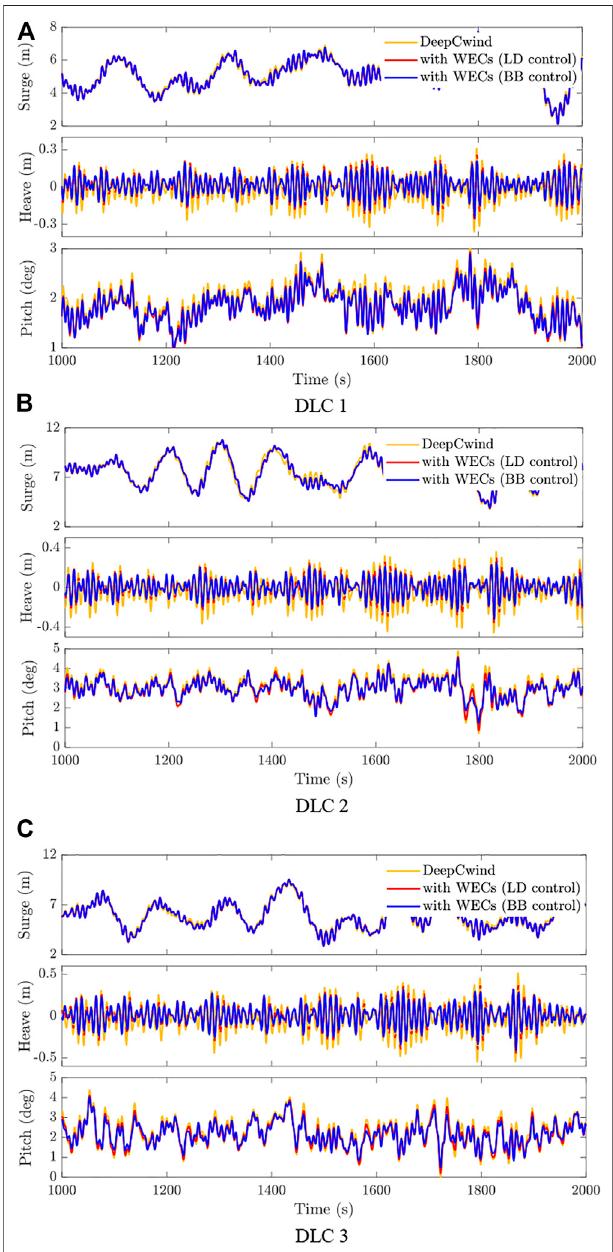
FIGURE 13 | Time series of platform motions with different PTO control strategies. (A) DLC 1. (B) DLC 2. (C) DLC 3.